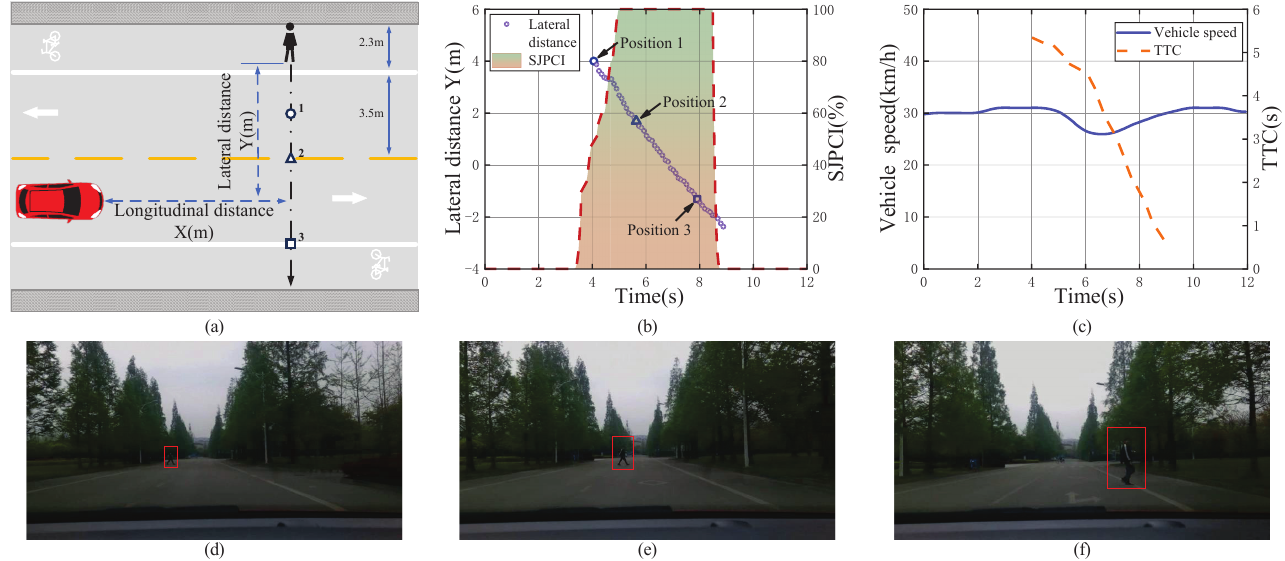
Figure 8. A moderate deceleration event when encountering a pedestrian crossing the street and the data analysis results. ( a ) Pedestrian–vehicle interaction schematic diagram; ( b ) Lateral distance and SJPCI; ( c ) Vehicle speed and TTC; ( d ) Position 1: Pedestrians started crossing the left lane line; ( e ) Position 2: Pedestrians walked to the center line; ( f ) Position 3: Pedestrians crossed the right lane